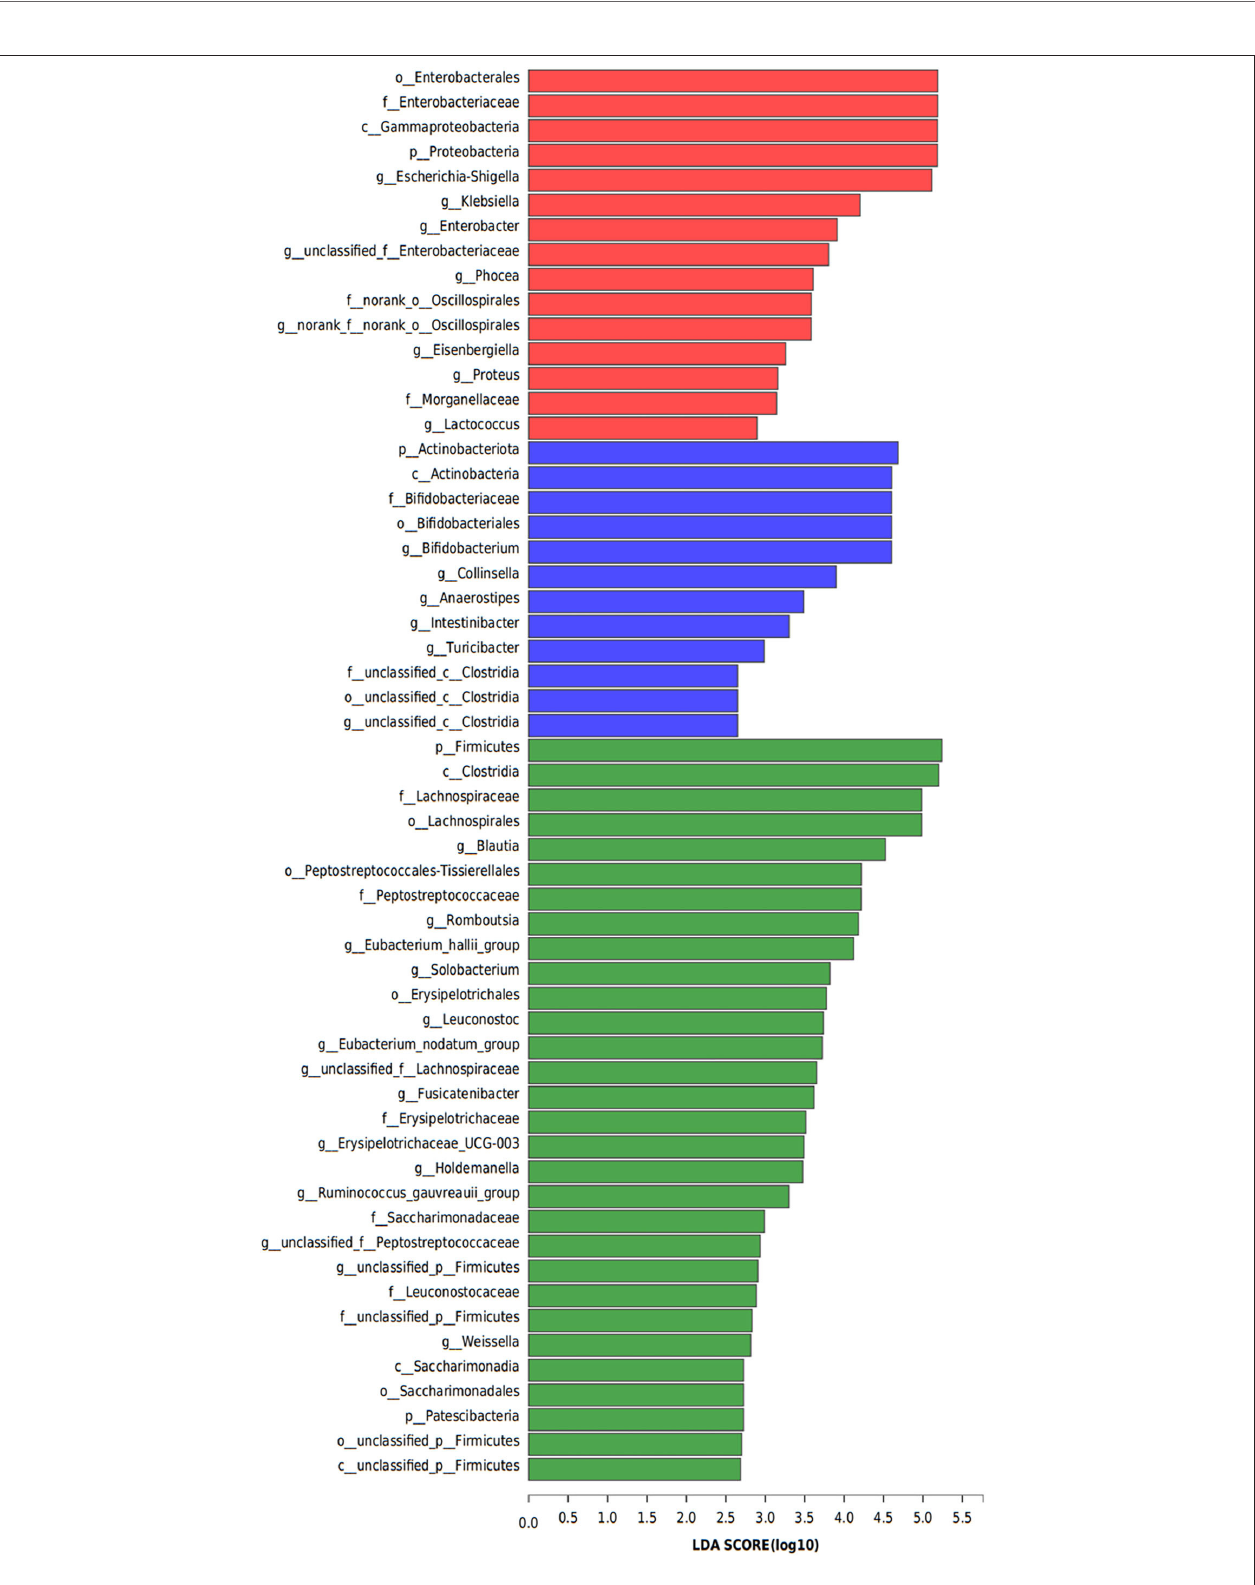
Frontiers in Microbiology |